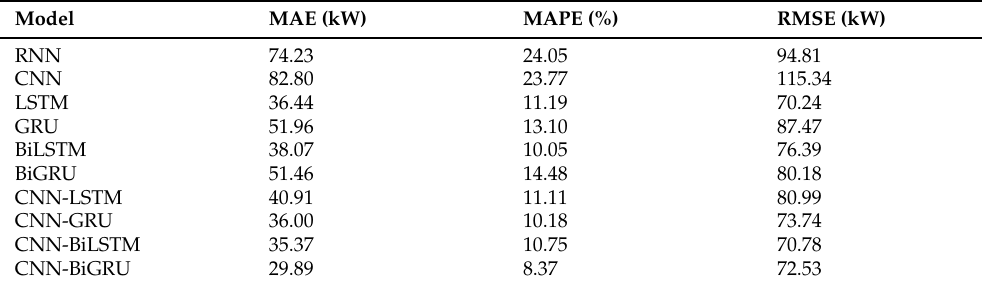
Figure 11. Performance comparison of the single model with one-day PV generation data on a cloudy weather day. Table 5. MAE, MAPE, and RMSE values of one-day PV generation forecasting on a cloudy weather